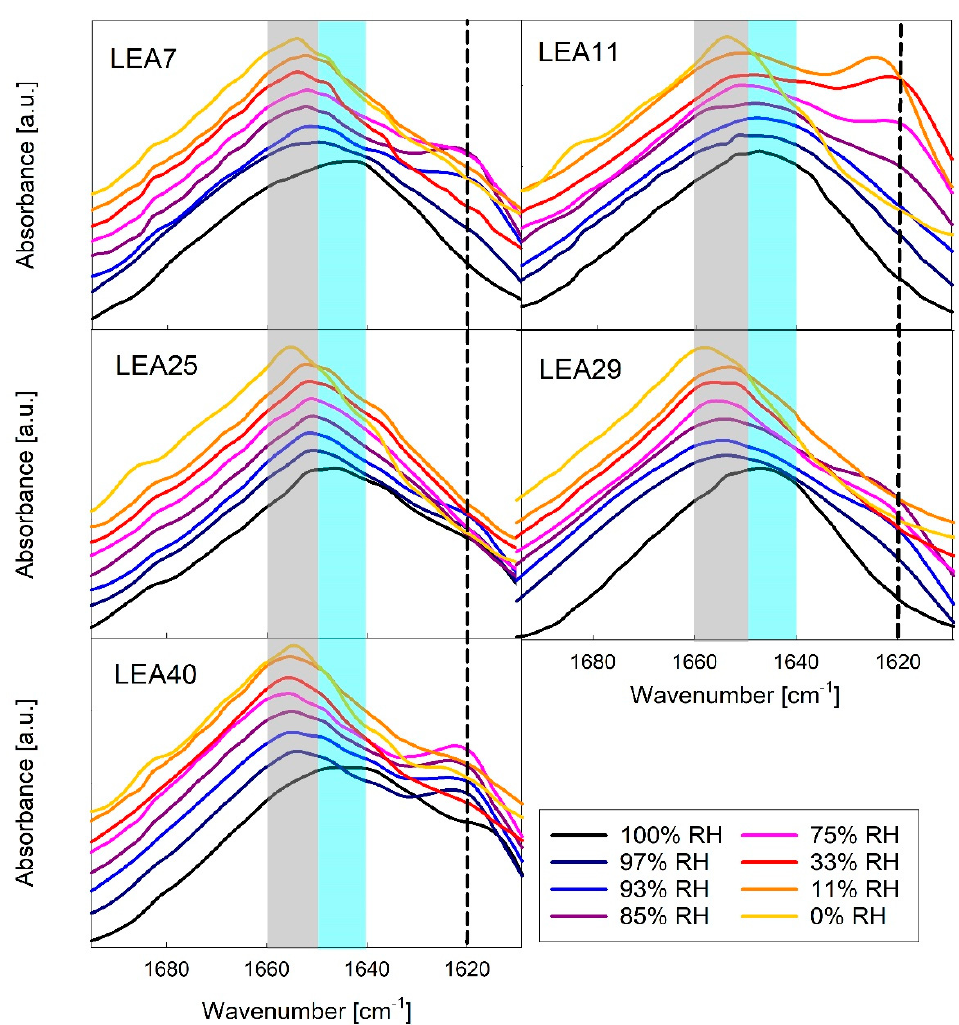
Figure 6. Amide I region of Fourier-transform infrared (FTIR) spectra of five out of the six LEA_4 family proteins in different relative humidity (RH) conditions. Peak maxima indicate unstructured proteins (1650–1640 cm -1 , shaded blue), α -helix (1660–1650 cm -1 , shaded grey) and β -sheet aggregates (about 1620 cm -1 , dashed line). The spectra in each panel are offset from each other for better visibility. A corresponding dataset for COR15A has been published previously [34].